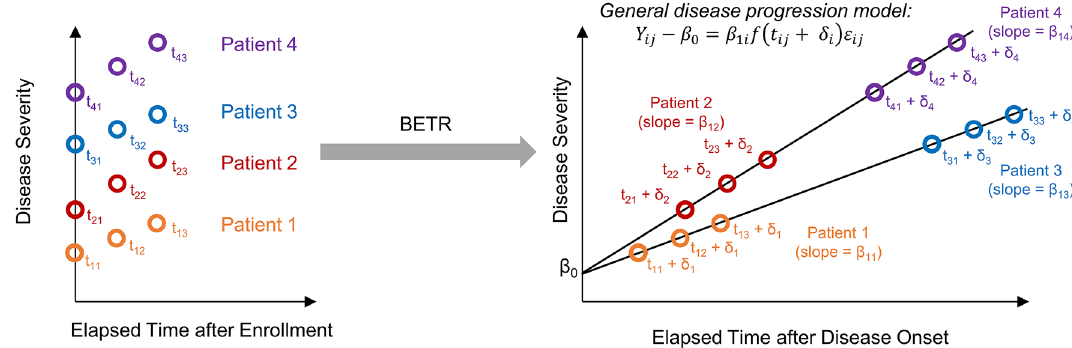
Figure 1. Overview of Bayesian entry time realignment (BETR) approach. Variables Y ij and t ij represent the disease severity and continuous time after enrollment into a study for patient i at visit j , respectively. β 0 represents the disease severity at the time of disease onset, which is assumed to be the same for all patients with the same disease; β 1 i is the disease progression rate for patient i ; δ i is the duration of disease at study enrollment for patient i . ε ij is the measurement error of disease severity for patient i at visit j . f ( t ) represents the disease progression model, which can be in different functional forms (e.g., linear, quadratic, exponential etc.). At the time of study enrollment (left figure), the 4 patients have different disease severities presumably because they entered the study at different time points of their individual disease courses (i.e., different δ i ). By applying BETR with a hypothesized disease progression model, we can estimate β 1 i , δ i , and ε ij for each patient and then horizontally realign the entry times of the patients by a factor of δ i onto the hypothesized model (right figure). If the hypothesized disease progression model is correct, the model should fit the datasets well with a low deviance information criterion and high intraclass correlation coefficient. In this way, we can infer the long-term natural history of a disease based on datasets with short follow-up durations. In this demonstration, β 11 = β 13 and β 12 = β 14 , and the correct disease progression model is the first order